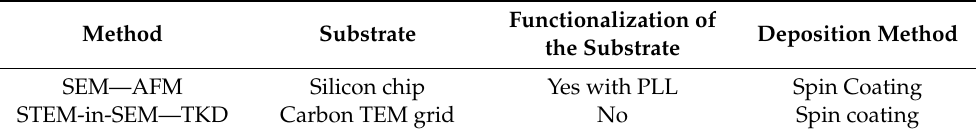
Table 1. Substrates and deposition method used according to the microscopy